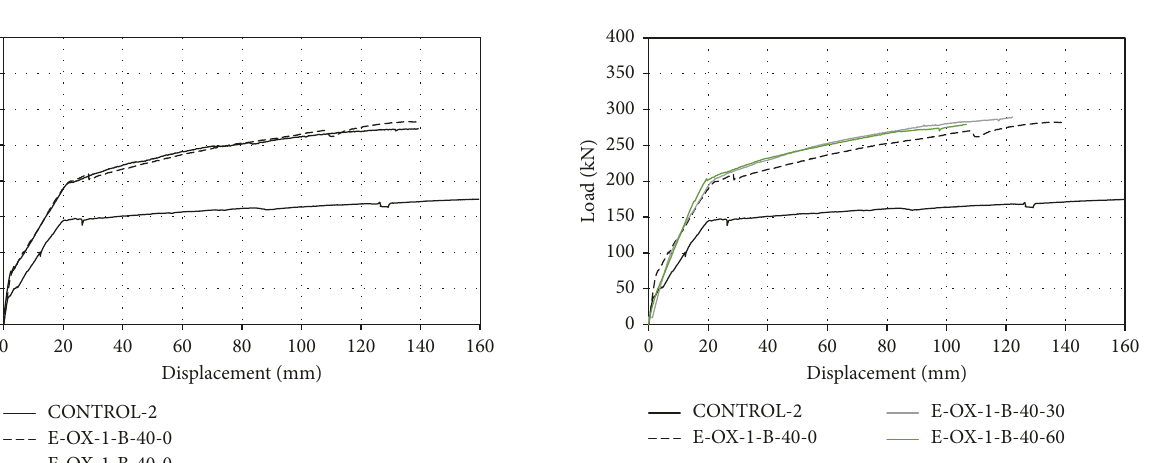
Figure 24: Strengthening effect w.r.t. damage extent of matrix.